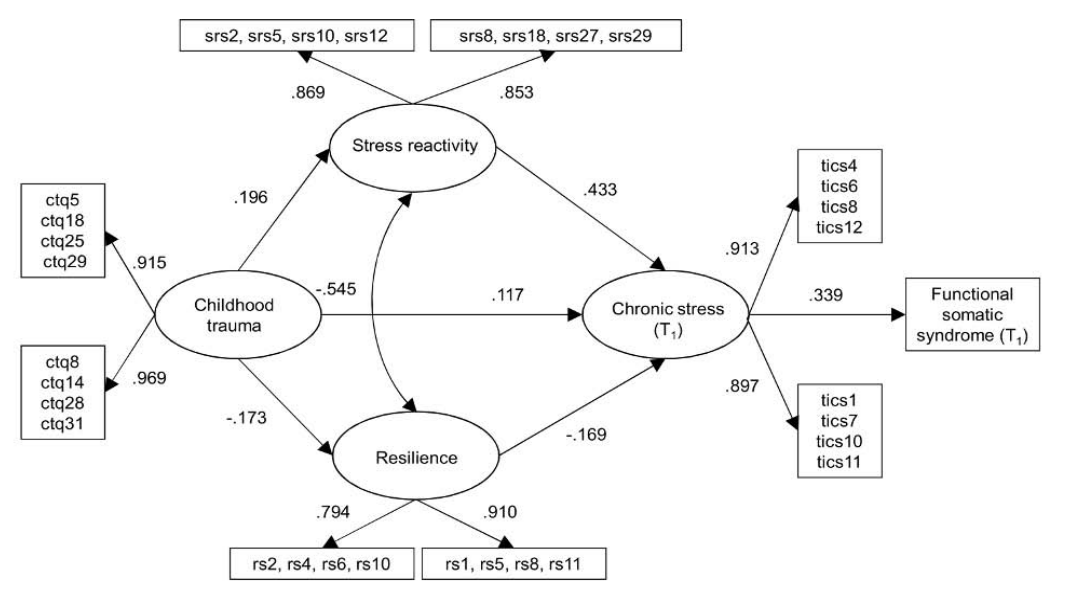
Figure 3. Longitudinal path analysis model: FSS on chronic stress including standardized path coefficients. ctqx = Childhood Trauma Questionnaire (T 0 ), indicator x. srsx = Stress Reactivity Scale (T 0 ), indicator x. rsx = Resilience Scale (T 0 ), indicator x. ticsx = Trier Inventory for the Assessment of Chronic Stress (T 1 ), indicator